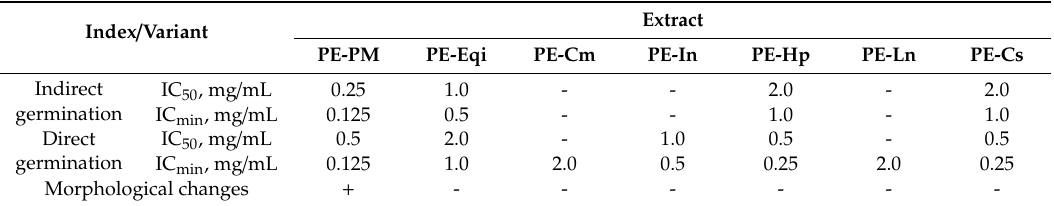
Table 1. Biological assays of peptide extracts on direct and indirect germination of Phytophthora infestans with application of microtiter-plate